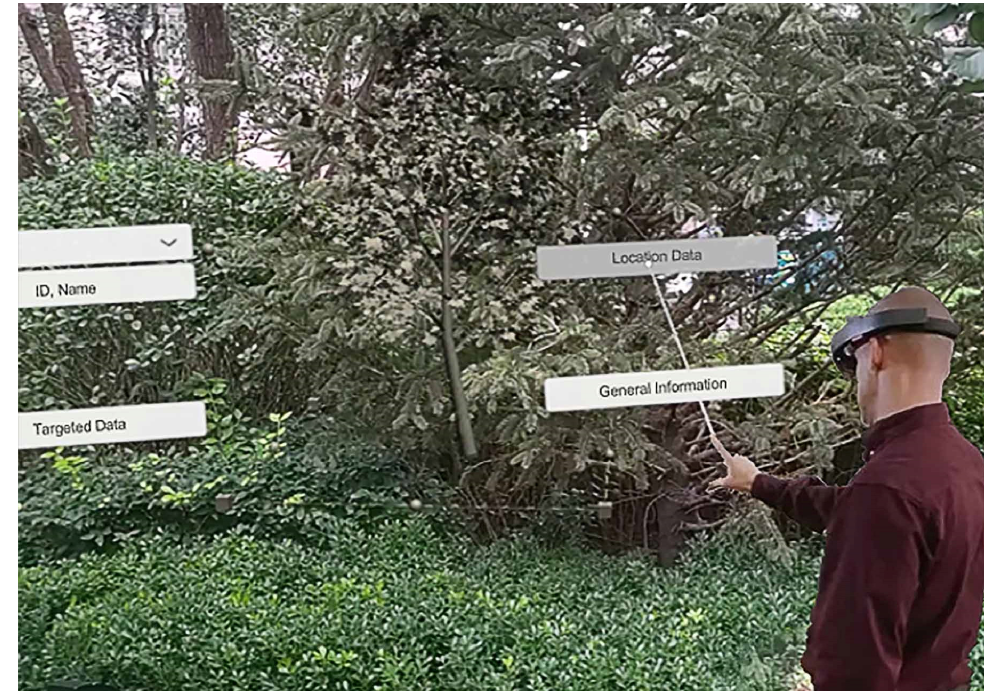
Figure 13. Interactive projection of virtual model on real landscape.